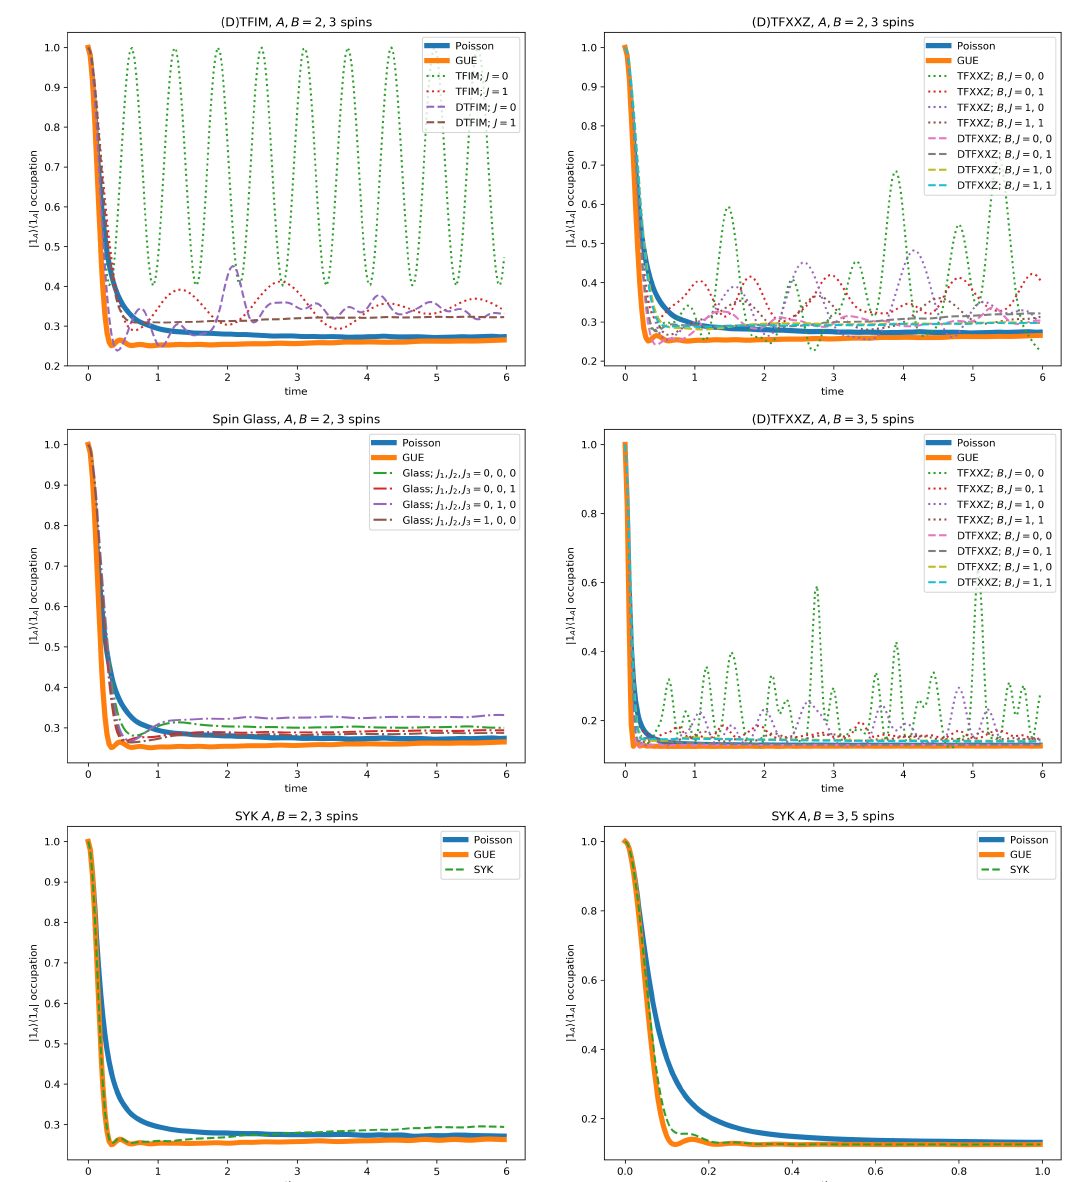
〉〈 1 | in ρ ( t ) over different model ensembles. A A A